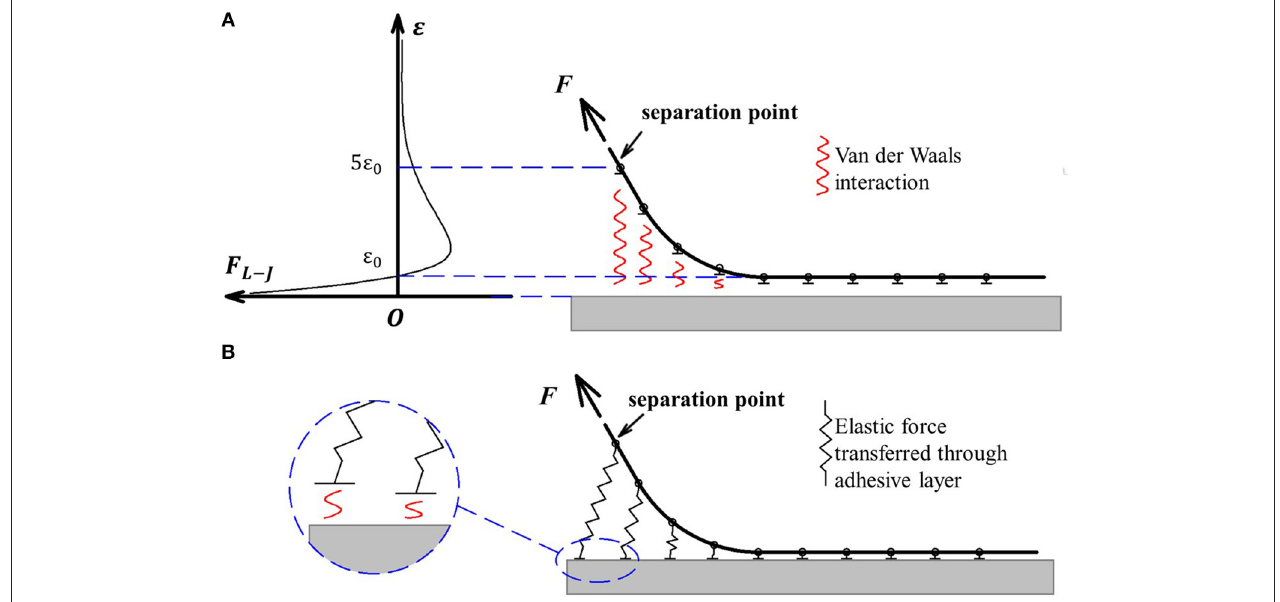
FIGURE 1 | Physical imagines of the peel zone description in Case 1 and Case 2 . (A) Case 1 : direct Van der Waals interaction between the tape and the substrate. (B) Case 2 :attractive force transferred through the adhesive layer.